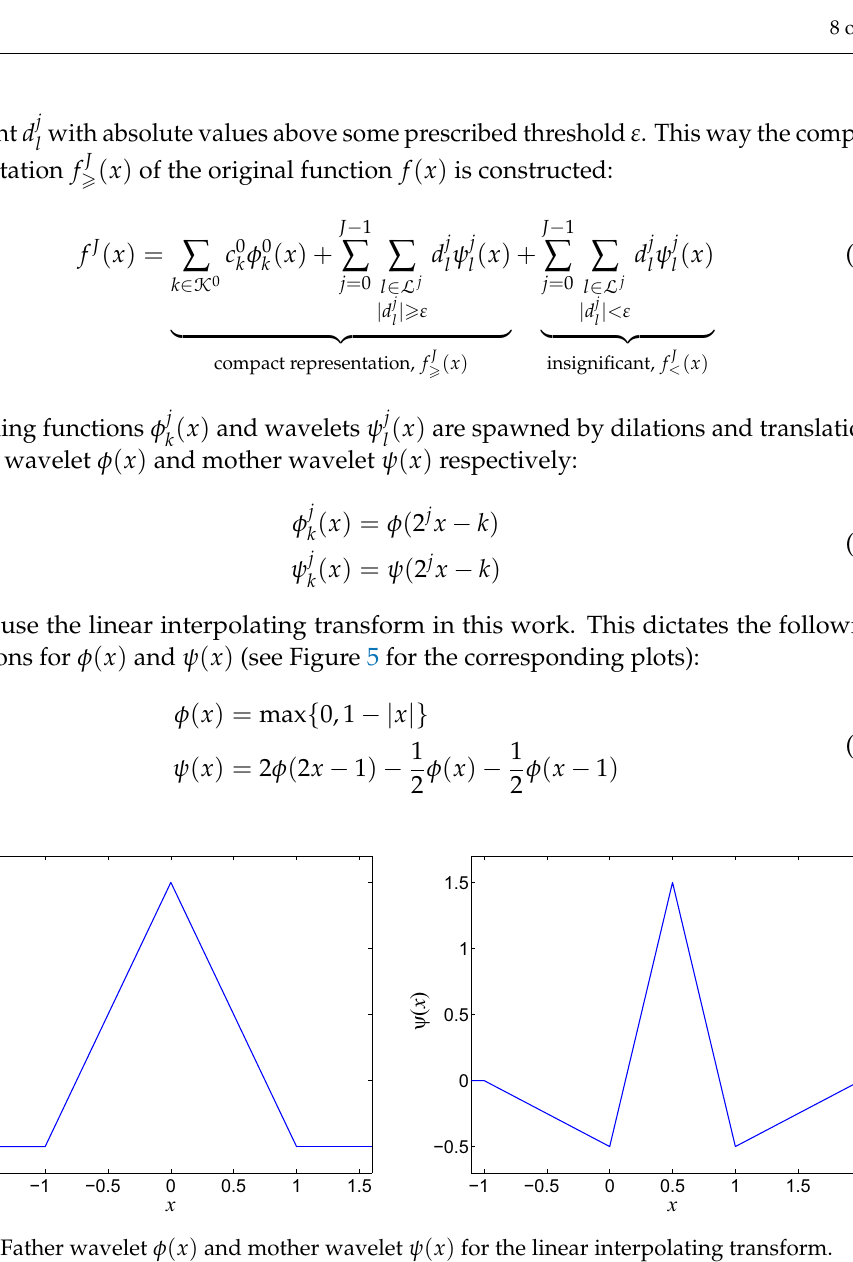
represent the coarsest resolution level, and levels k , j = 0 . . . 4 respectively. Note how l